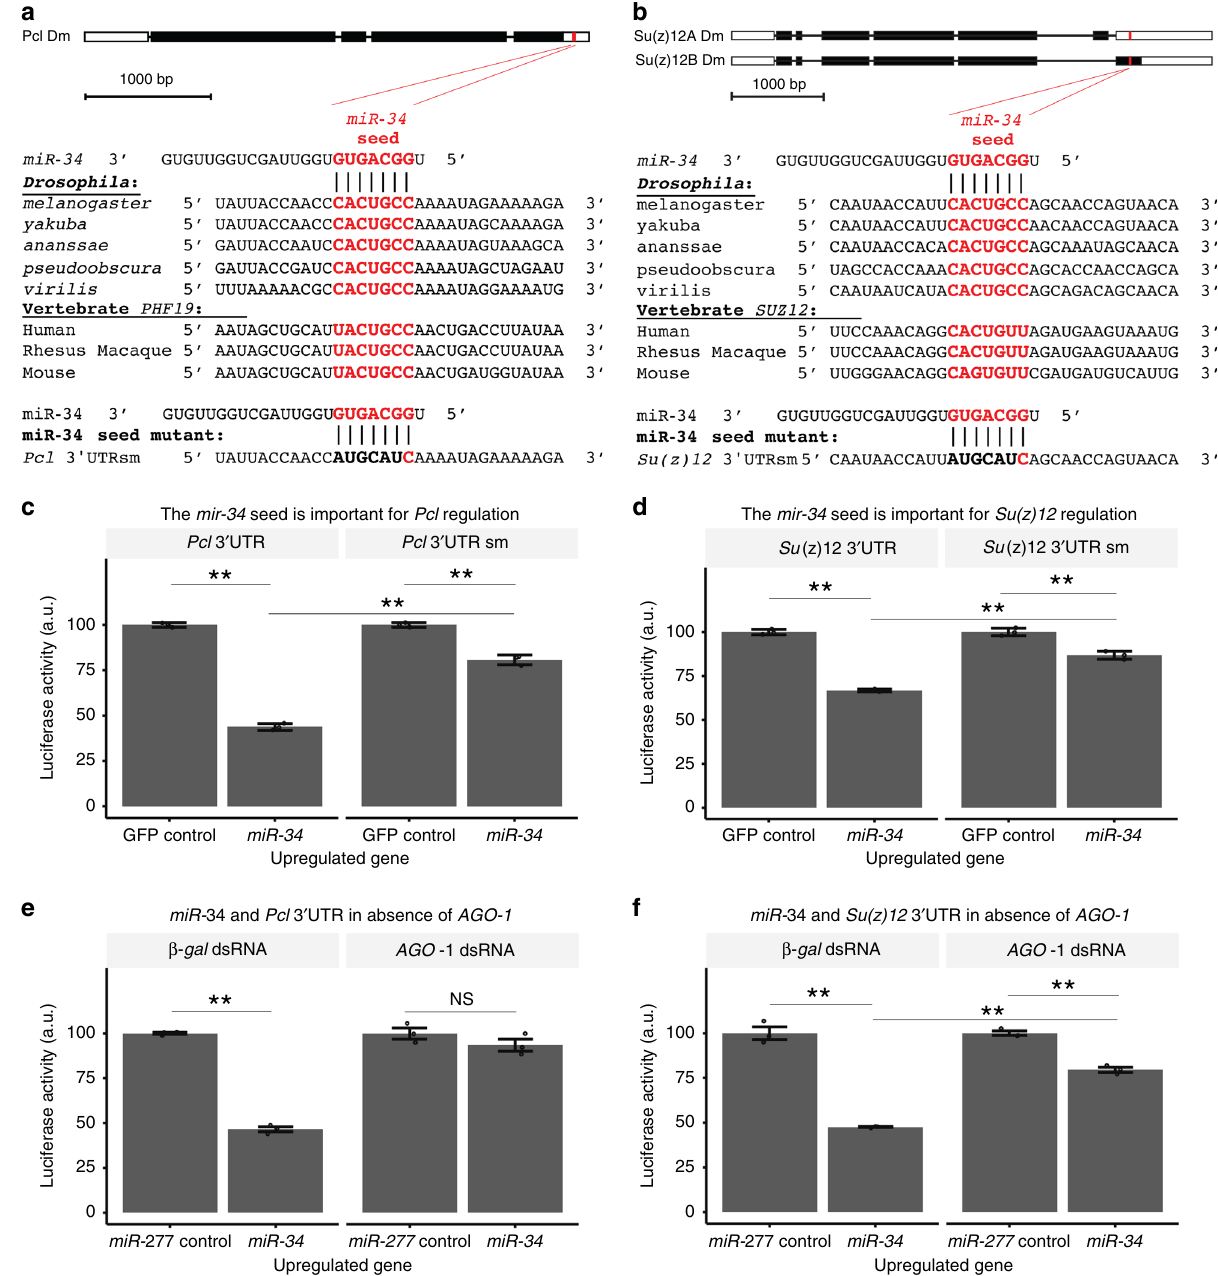
Fig. 1 miR-34 targets 3 ′ UTRs of Su(z)12 and Pcl. a , b Pcl and Su(z)12 are predicted targets of miR-34 . The seed sequence of miR-34 has complementarity with the ( a ) Pcl 3 ′ UTR and the ( b ) Su(z)12 3 ′ UTR. The seed sequence is conserved in various homologs. Bottom, an engineered mutation in the seed sequence was also generated, red letters indicate base-pairing retained in the seed mutation, those with disrupted base-pairing are in black. c , d Luciferase assays con fi rm that miR-34 targets Pcl and Su(z)12 . A reporter construct containing the 3 ′ UTR of ( c ) Pcl or ( d ) Su(z)12 fused to Renilla luciferase was expressed in Drosophila SL2 cells and tested for a response to miR-34 . Upon miR-34 upregulation, luciferase activity decreases in reporters containing the ( c , left) Pcl 3 ′ UTR and the ( d , left) Su(z)12 3 ′ UTR. Regulation of the Pcl 3 ′ UTR by miR-34 was attenuated by a seed sequence mutation ( c , right). Regulation of the Su(z)12 3 ′ UTR by miR-34 was also attenuated by the seed sequence mutation ( d , right). Two-way ANOVA indicated a signi fi cant interaction term for the Pcl 3 ′ UTR (F 1,8 = 8.5, p < 0.02), and Su(z)12 3 ′ UTR (F 1,8 = 17.5, p < 0.01). ** p < 0.01, two-way ANOVA with Tukey post-test. Mean ± SEM, n = 3 wells. e , f The RNAi induced silencing complex (RISC) is required for regulation of the 3 ′ UTR of Pcl and Su(z)12 by miR-34 . The 3 ′ UTR reporter constructs were expressed in DL1 cells treated with dsRNA to argonaute-1 (an essential component of RISC) or a control gene ( β -gal ). The cells were tested for a response to upregulation of miR-34 or a control microRNA ( miR-277 ). In cells treated with β -gal dsRNA, upregulation of miR-34 resulted in decreased reporter expression. In cells treated with AGO1 dsRNA, the effect of miR-34 on reporter expression was eliminated ( e , for Pcl 3 ′ UTR reporter two-way ANOVA indicated a signi fi cant interaction term, F 1,8 = 107, p < 0.01) or attenuated ( f for Su(z)12 3 ′ UTR reporter two-way ANOVA indicated a signi fi cant interaction term, F 1,8 = 73, p < 0.01). ** p < 0.01, Two-way ANOVA, Tukey post-test. Mean± SEM, n = 3